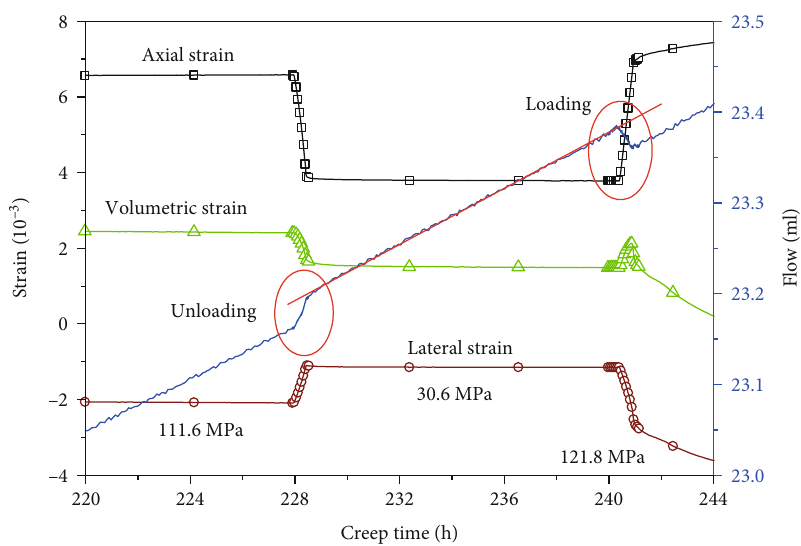
Figure 11: The relationship between the seepage fl ow and creep strain versus time during loading and unloading